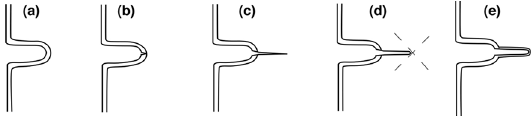
Figure 3. SCC mechanism: formation of a brittle surface film at the crack tip 28